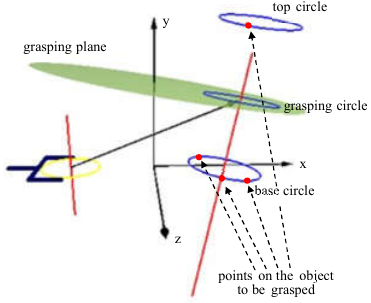
Figure 5. Grasping Figure 5. Grasping algorithm. Table 9. Grasping algorithm profiling.